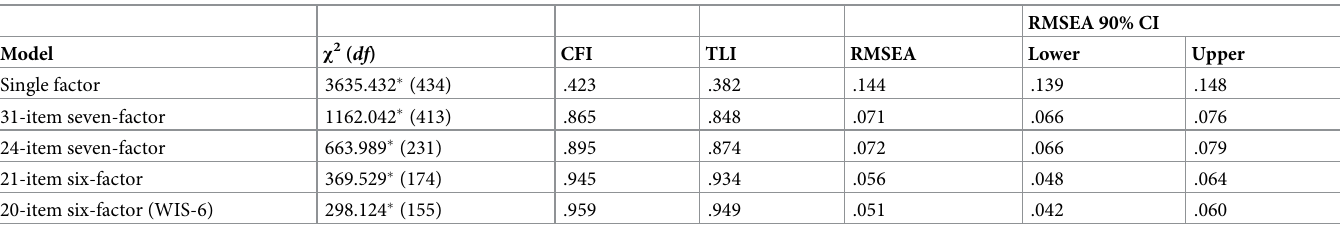
Table 2. Summary of fit statistics for tested Warrior Identity Scale